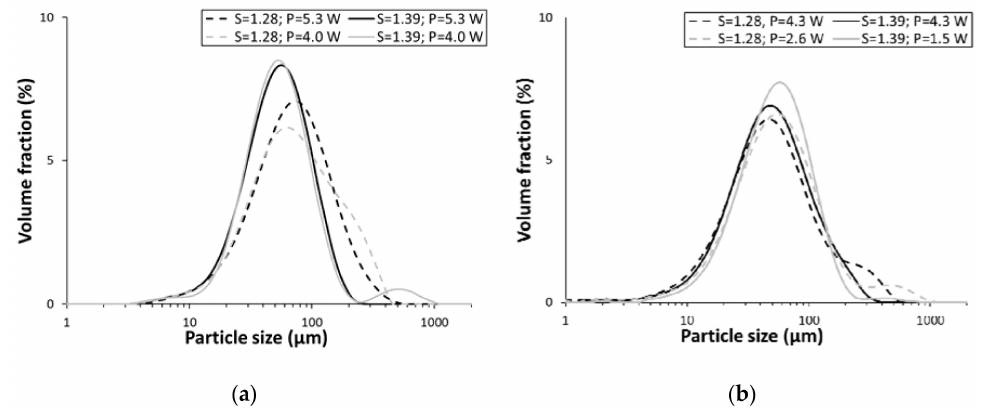
Figure 3. Particle size distributions after filtration obtained for ( a ) the ultrasound probe, and ( b ) the rotor–stator